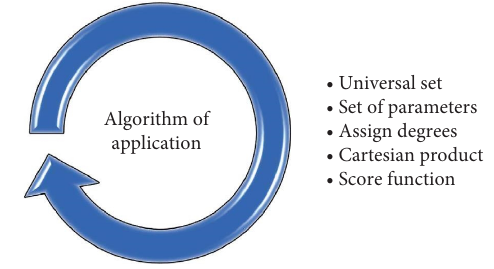
Figure 1: Algorithm of application.